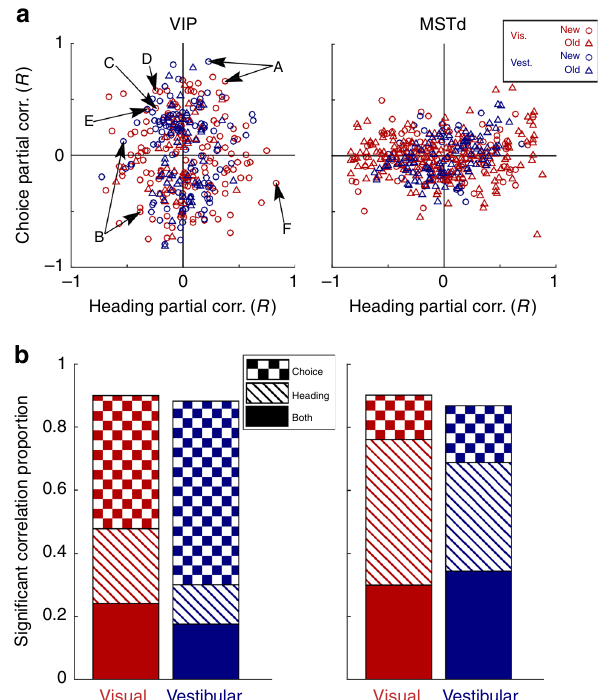
Fig. 2 Heading and choice partial correlations. Partial correlations were calculated between neuronal fi ring rates and stimulus headings (given the actual choices made by the monkey) or choices (given the stimulus headings). Only cells that showed a signi fi cant main effect of heading or choice were included ( p < 0.05, two-way ANOVA). a Partial correlations are presented as scatterplots for VIP ( left ) and MSTd ( right ). Red and blue symbols represent the data from the visual and vestibular conditions, respectively, and circle and triangle symbols represent the new and old data sets, respectively. Arrows indicate the data points corresponding to the VIP tuning curves presented in Fig. 1 (letters A – F for the respective Fig. 1 subplots). b The proportion of neurons (same data as in a ) with signi fi cant partial correlations for choice-only, heading-only or both heading and choice. In VIP, neurons with signi fi cant choice partial correlations are prevalent; while MSTd shows a greater proportion of signi fi cant heading partial correlations. In b , the new and old data were pooled for each brain area (results were similar for each data set individually). For VIP new (old) data, N = 140 (50) and 95 (58) for visual and vestibular conditions, respectively. For the MSTd new (old) data, N = 80 (217) and 25 (97) for visual and vestibular conditions, respectively. See also Supplementary Fig.